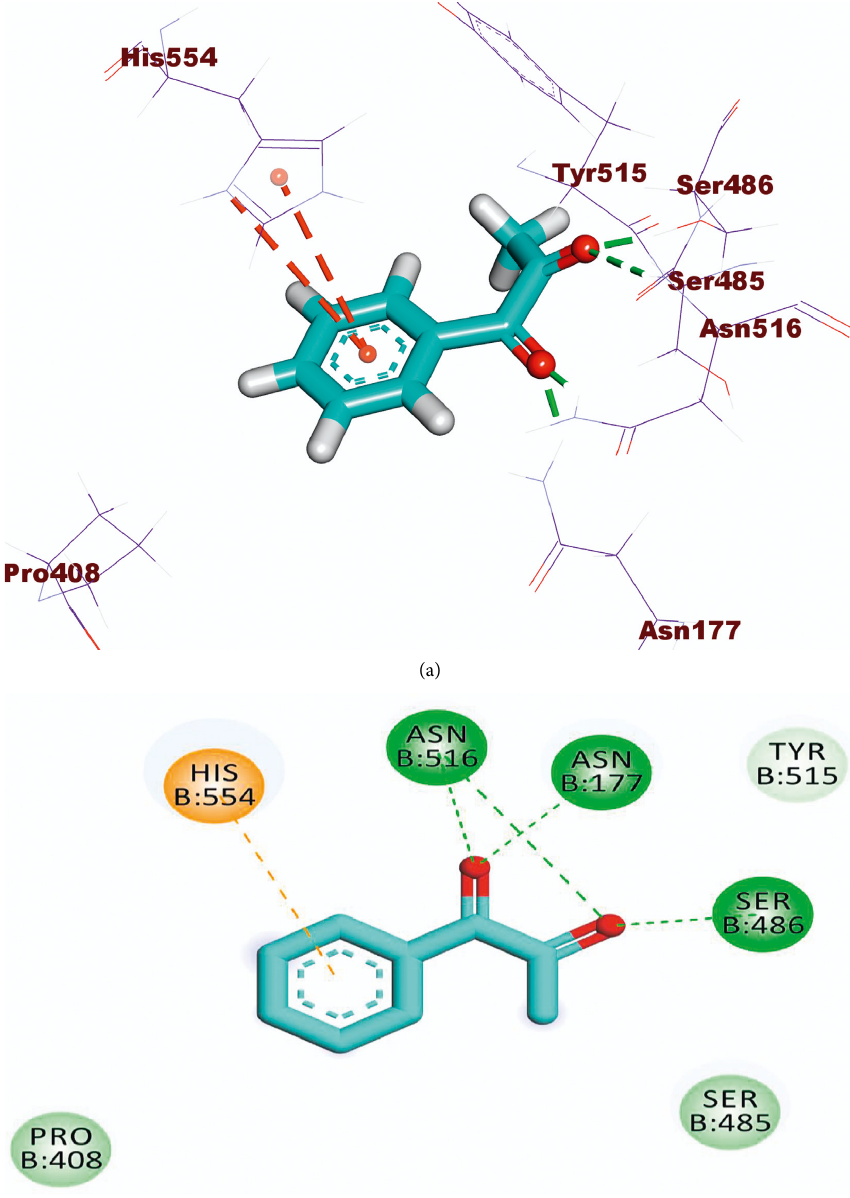
Figure 9: (a) 3D and (b) 2D images of the docked compound 195 into the active site of SARS-CoV-2